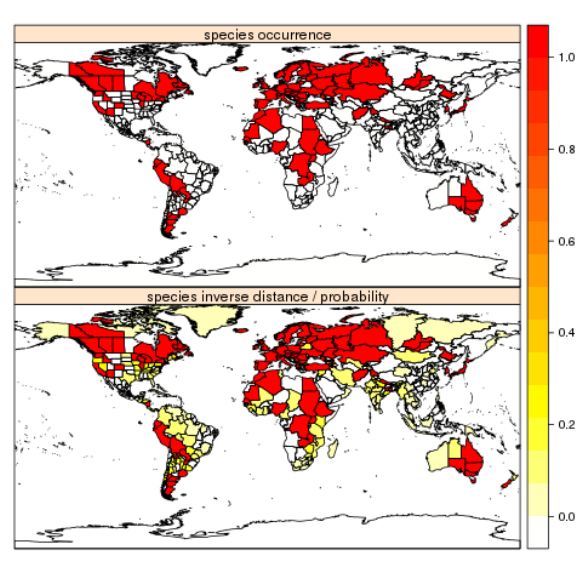
Figure 6: Representation of the presence of the foraminifera species Keratella quadrata and the probability (as inverse dis- tance) of occurrence of each determined individual to that species. While the presence / absence map has obviously only red (1 - presence) and white (0 - absence) colour, the probability map based on inverse distance covers the whole range of decimal values from 0 to